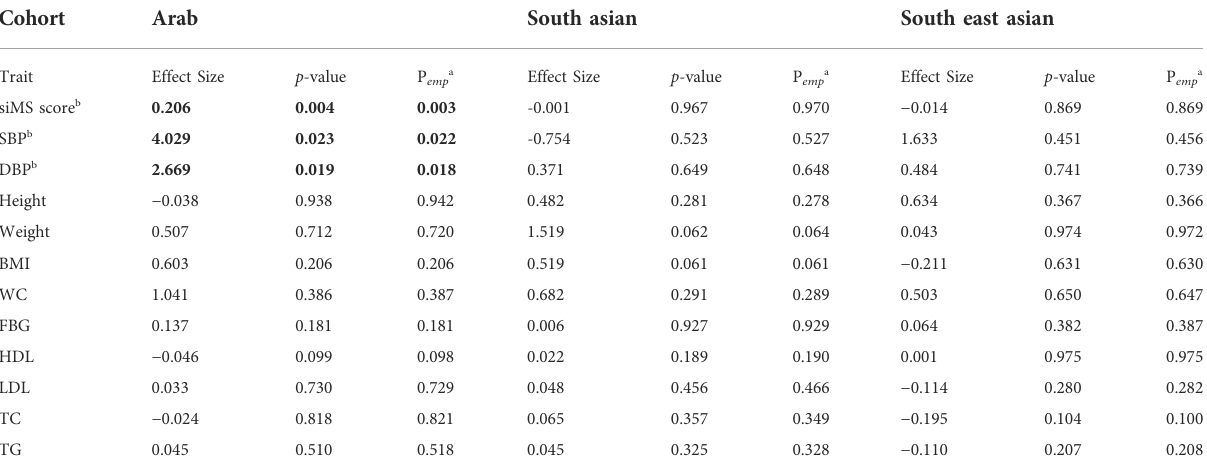
TABLE 3 Summary statistics of quantitative trait association with rs1997623_A in Arab, South Asian and South East Asian cohorts using linear regression adjusted for Age and Sex. Cohort Arab South asian